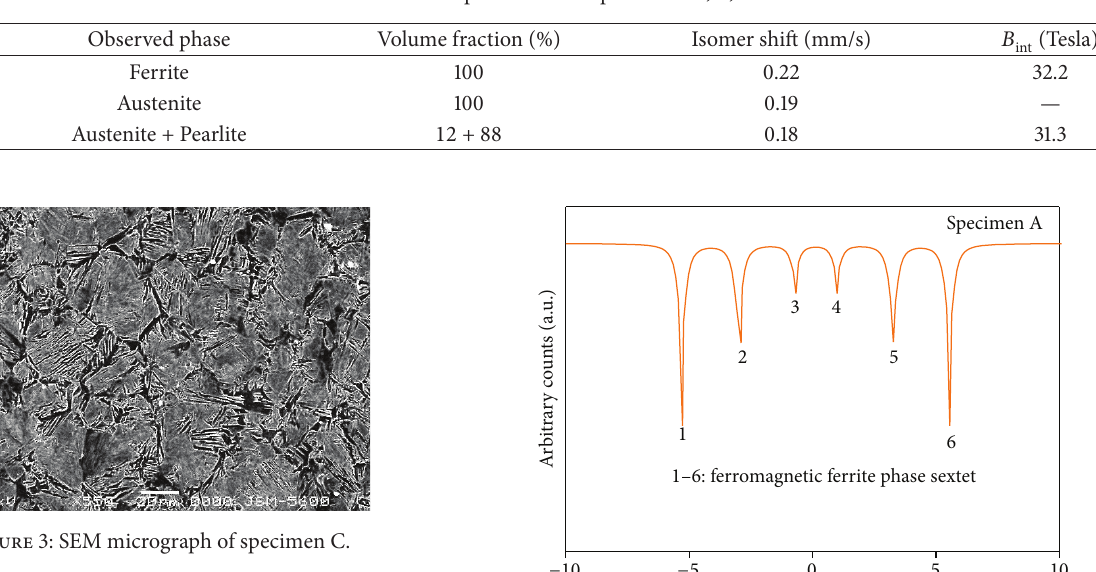
Table 2: Determined M¨ossbauer parameters of specimens A, B, and C.